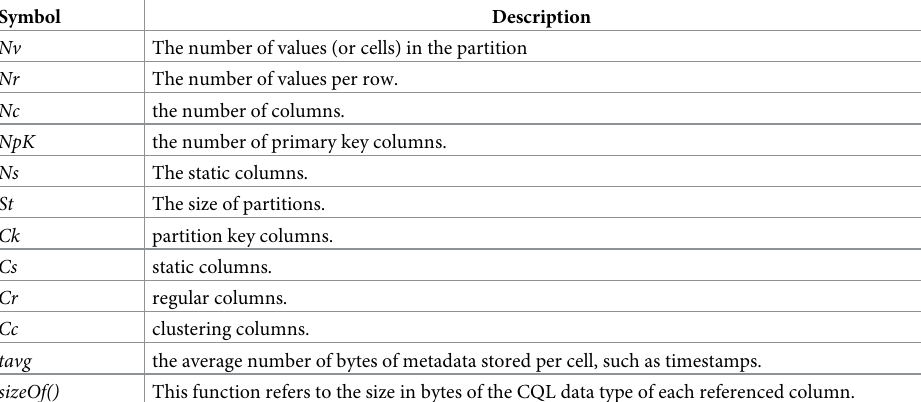
Table 2. The partitions variables used in this